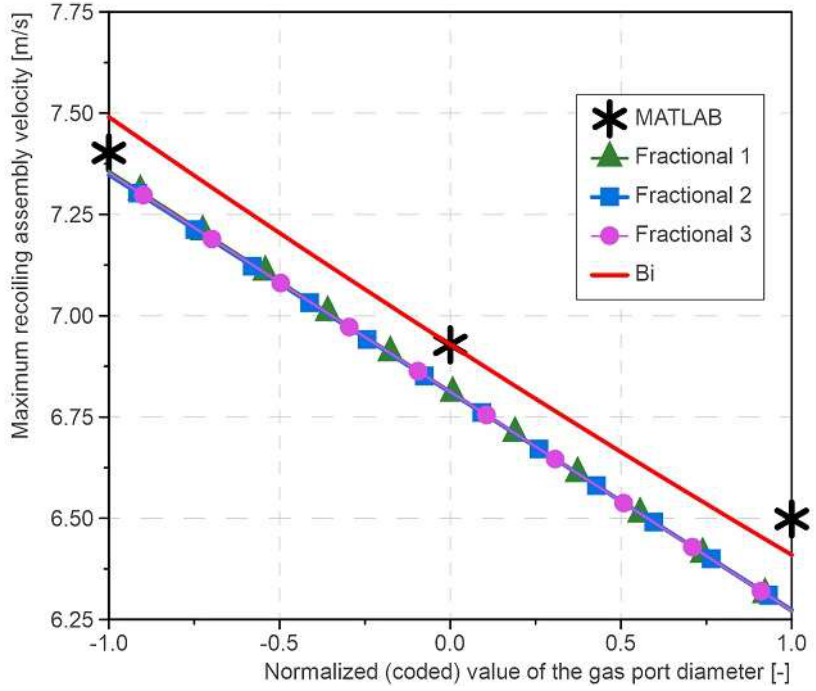
Figure 3. Diagram of the maximum recoiling assembly velocity as a function of the normalized (coded) value of the gas port diameter.